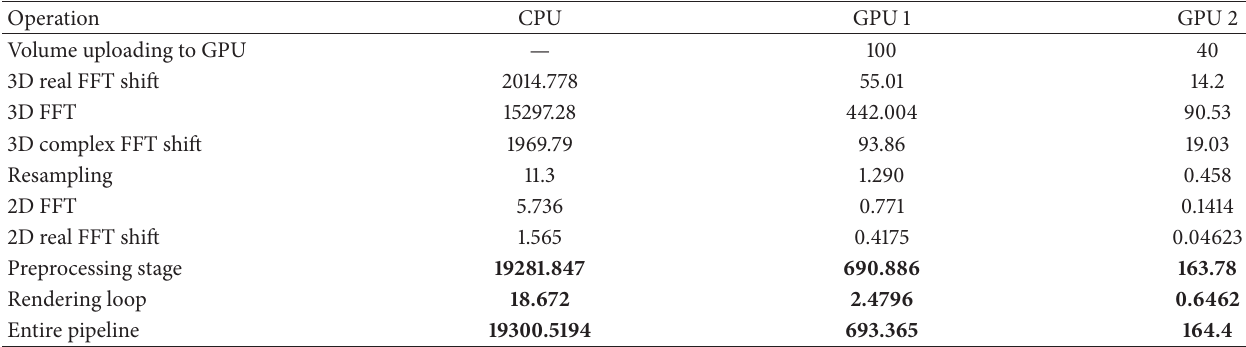
Table 1: Performance benchmarks comparison between the different stages of the computational context on the CPU versus GPU for processing a volume of 512 3 . All the results are in milli-seconds